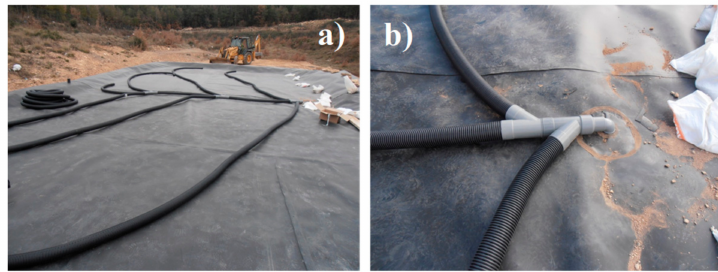
Figure 4. ( a ) Image of the distribution of the pipes as fish spines. ( b ) Detail of the pipes unification before collecting the leachates in the collection tank.